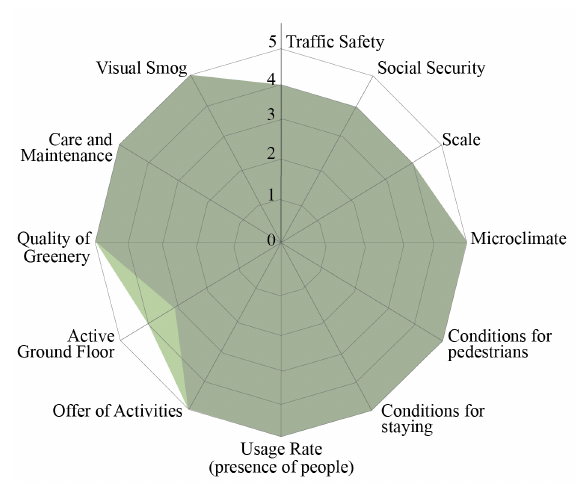
Figure 1. Ray diagram showing the assessment of the quality of the public space that surrounds Smetana park in Pilsen, Czechia. Figure readapted by authors from Sedlak et al.